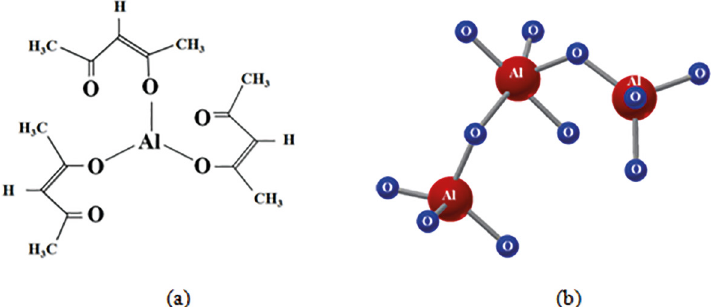
H O ) and 15 21 6